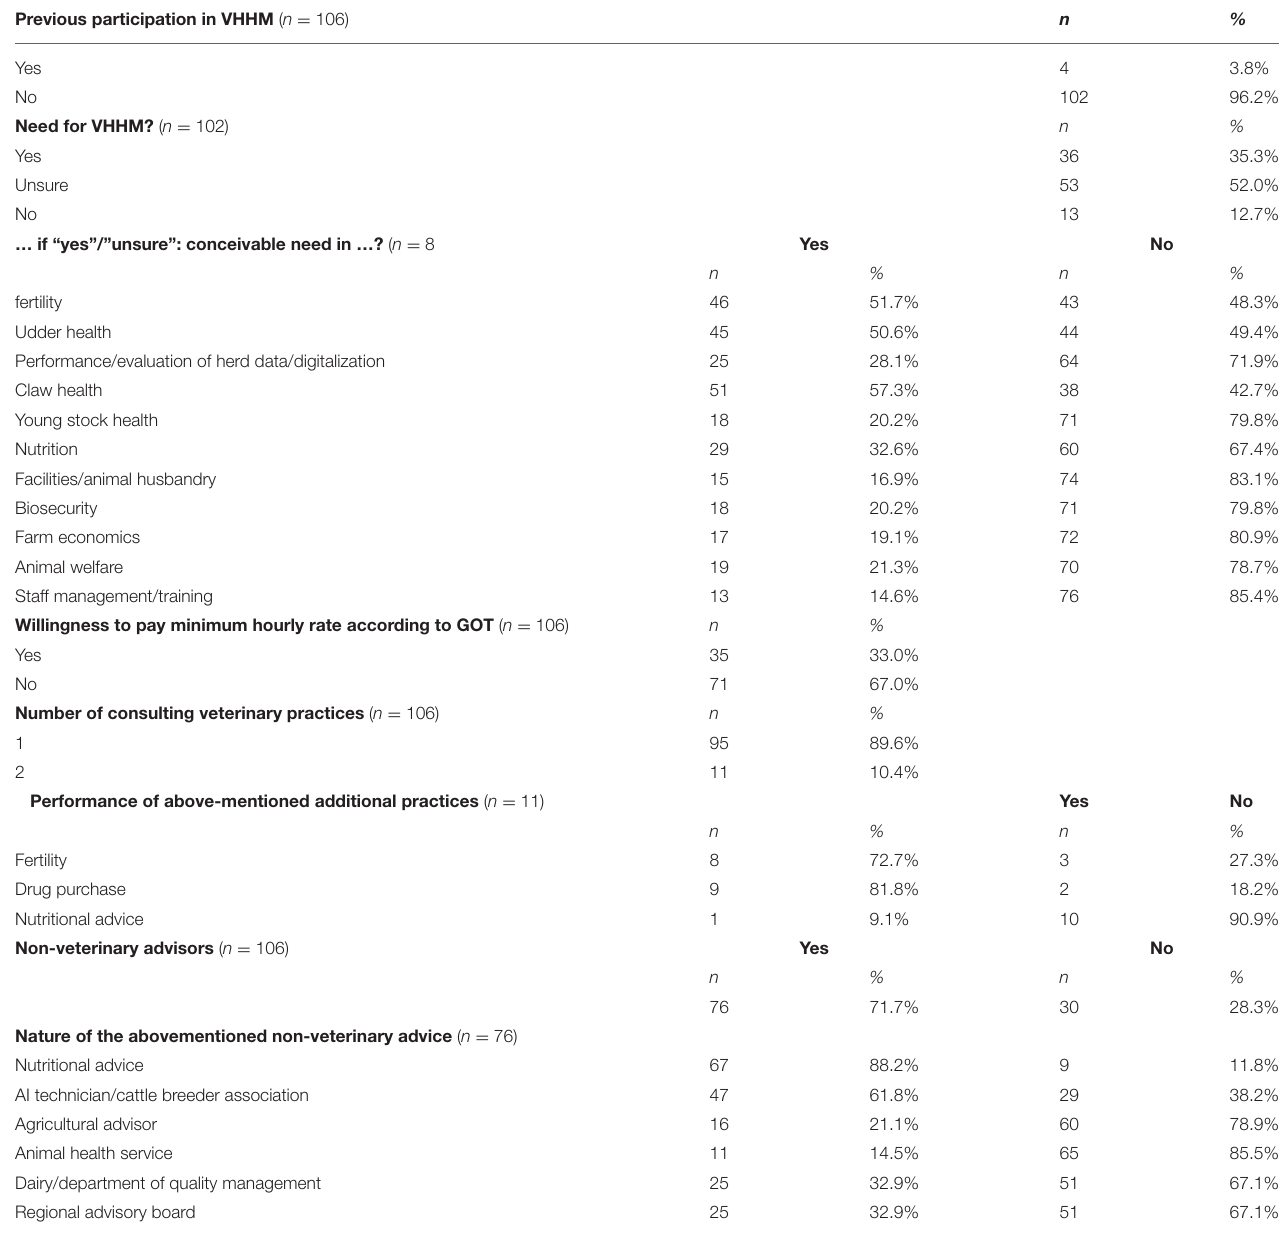
TABLE 9 | No VHHM participation: Descriptive data. Previous participation in VHHM ( n =